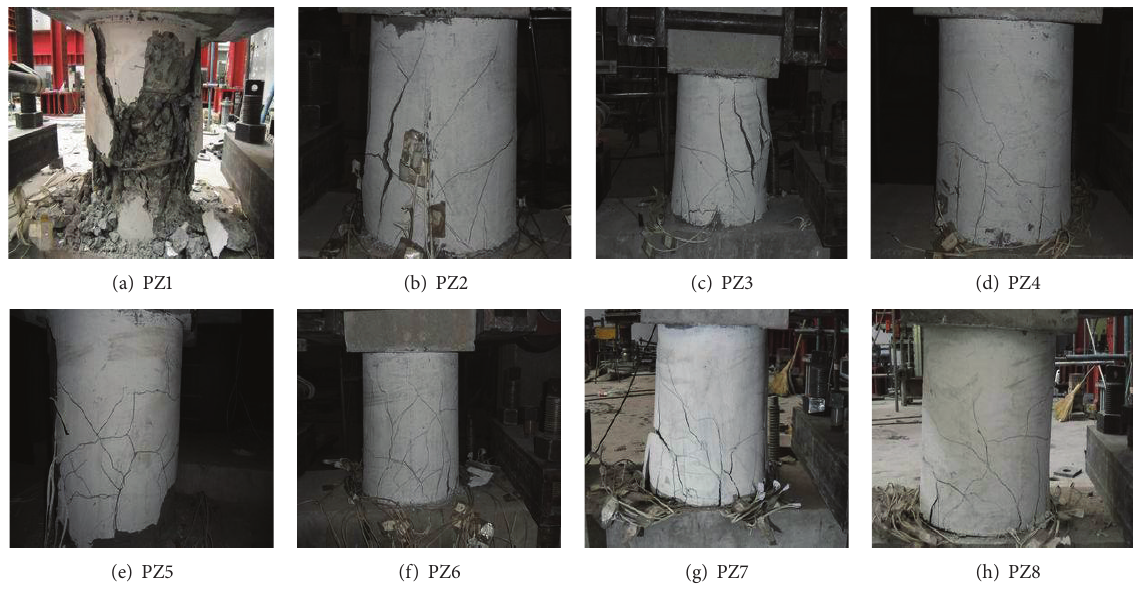
Figure 4: Failure patterns of